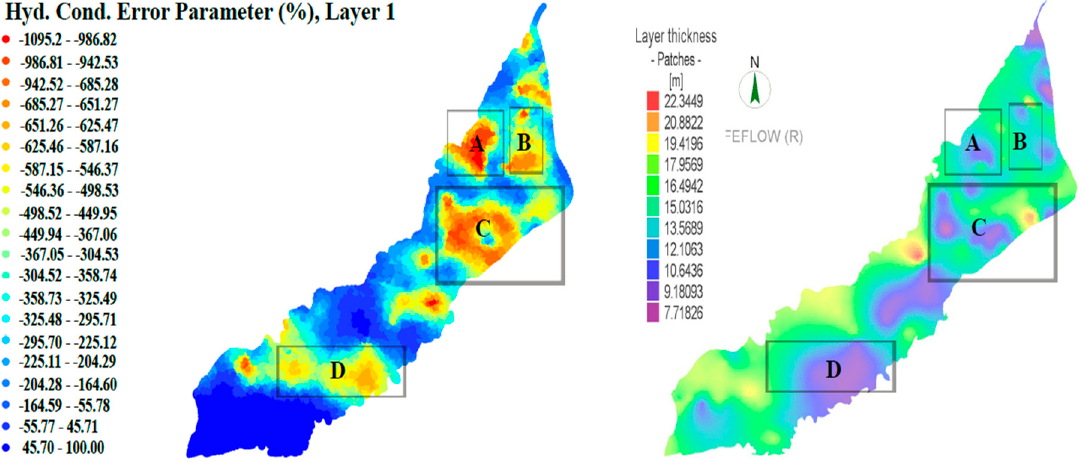
Figure 11. Distribution of parameter error range for hydraulic conductivity and thickness of the 1st model layer. (Note that the parameter error for other layers is available as Supplementary Material).